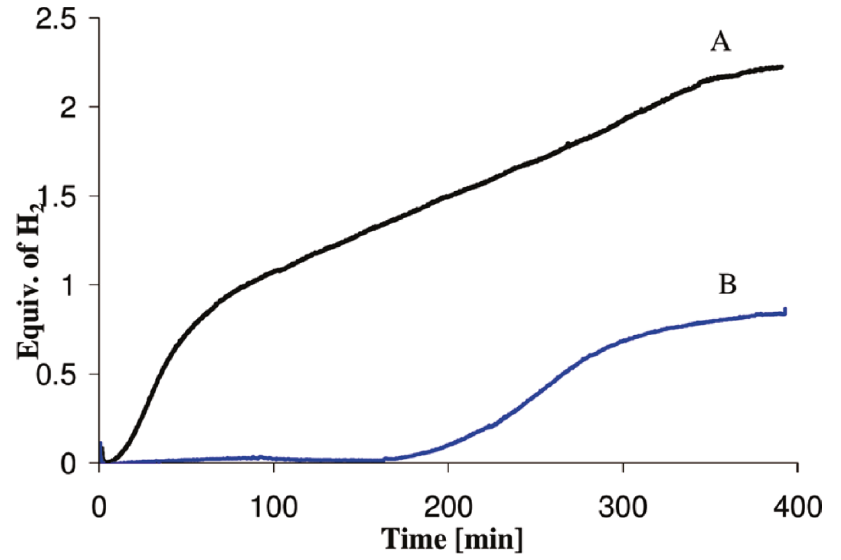
Figure 6. Hydrogen release measurements via gas buret at 85 °C for a 50:50 mixture of AB (150 mg):BmimCl (curve A) and 150 mg of neat solid-phase AB (curve B); data reproduced from [22].